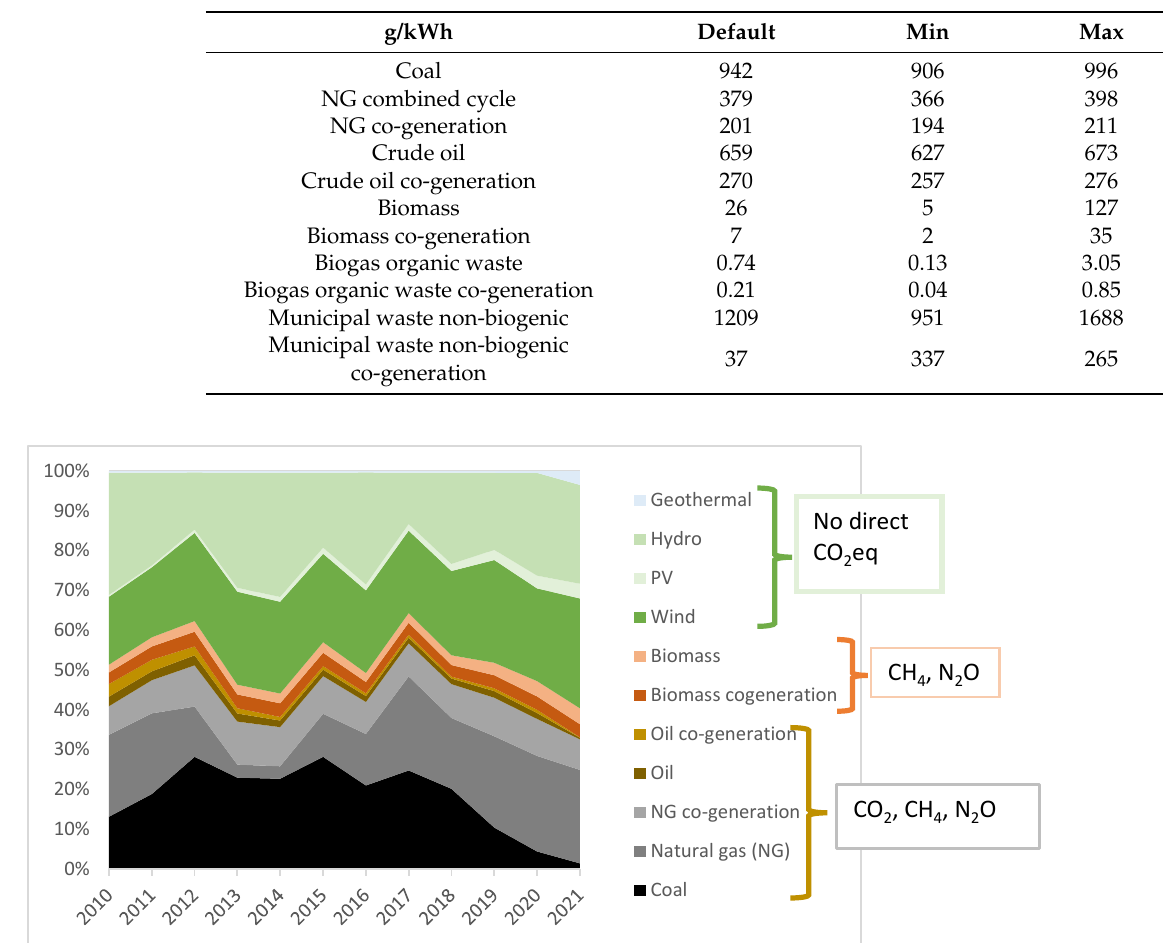
Table 3. IPCC AR6 CO 2 eq for each technology [24,26].